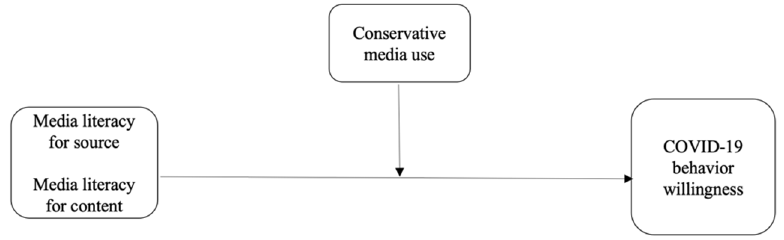
Figure 1. The conceptual